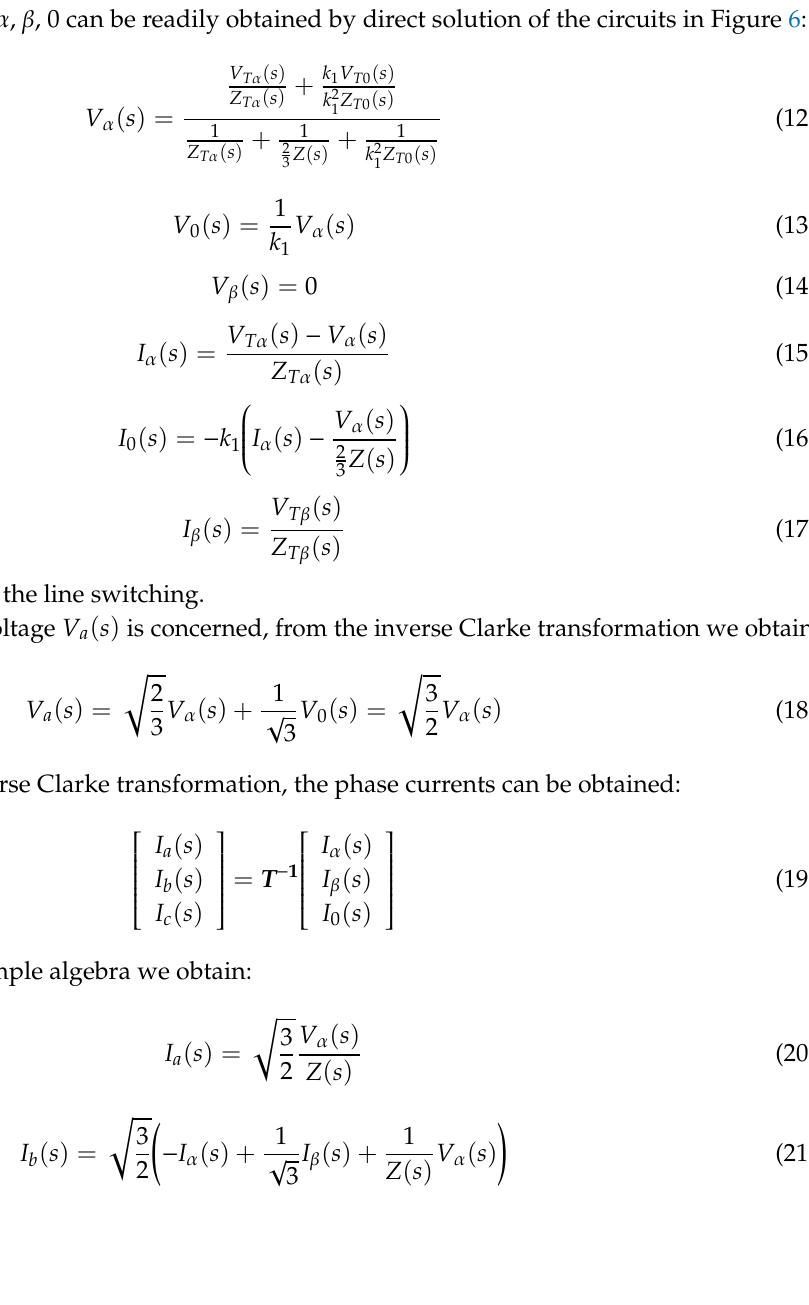
Figure 6. Connection of Thevenin modal circuits in the Laplace domain. Line switching of phase a result in ( a ) coupled α and 0 circuits through an ideal transformer with ratio k 1 = uncoupled and shorted steady-state circuit β